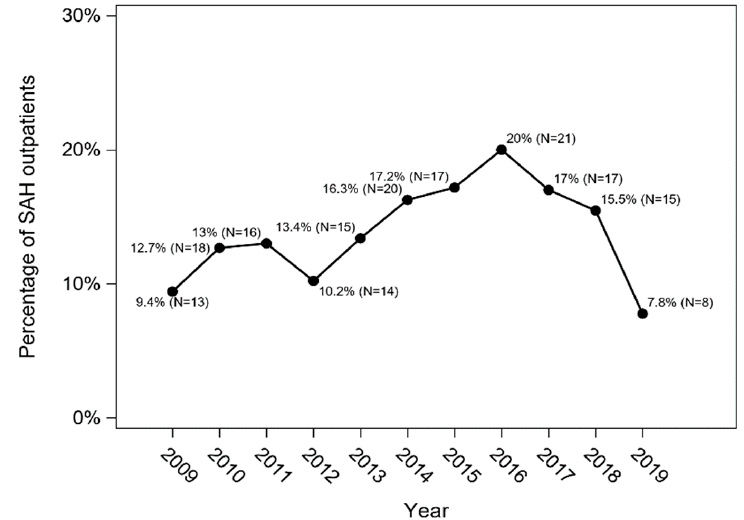
Figure 6. The overall post-discharge 12-month mortality in SAH patients (Cochran–Armitage trend test: p = 0.197).